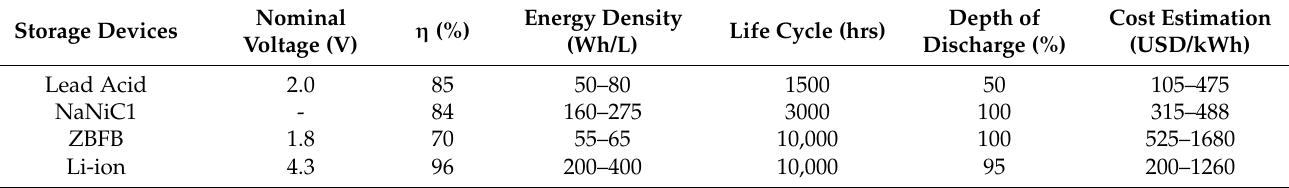
Table 1. Comparison of different energy storage devices [16–19].